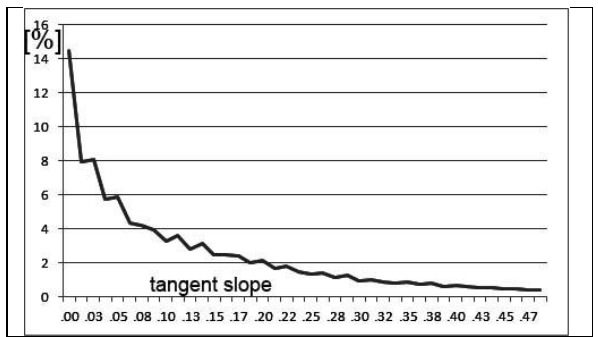
Fig. 4 : distribution of terrain inclination